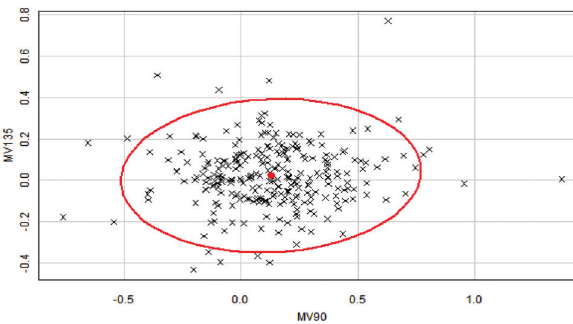
Figure 1 - Bivariate analysis of the influence of the parameters magnitude vector 90 and magnitude vector 135 on differences between right-eye refraction values obtained under cycloplegia by Spot Vision Screening TM and by subjective clinical refracto- metry in a sample of 134 healthy Brazilian volunteers. Magni- tude vector 90: magnitude vector on the 90 o axis; MV 135: difference between diopter components projected on the 135 o axis and the 45 o axis.